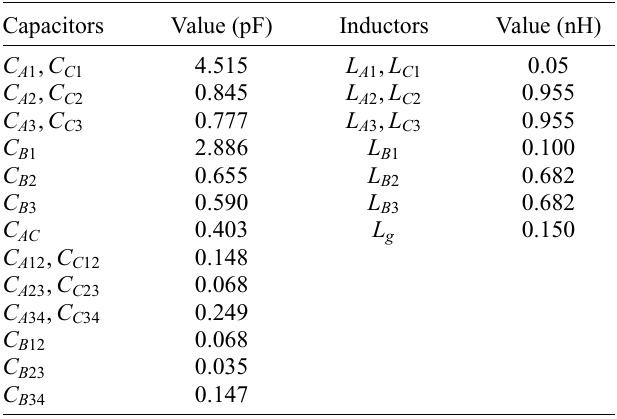
TABLE I. Values of circuit components appearing in Fig. 19(b), and used in the simulation shown in Fig.